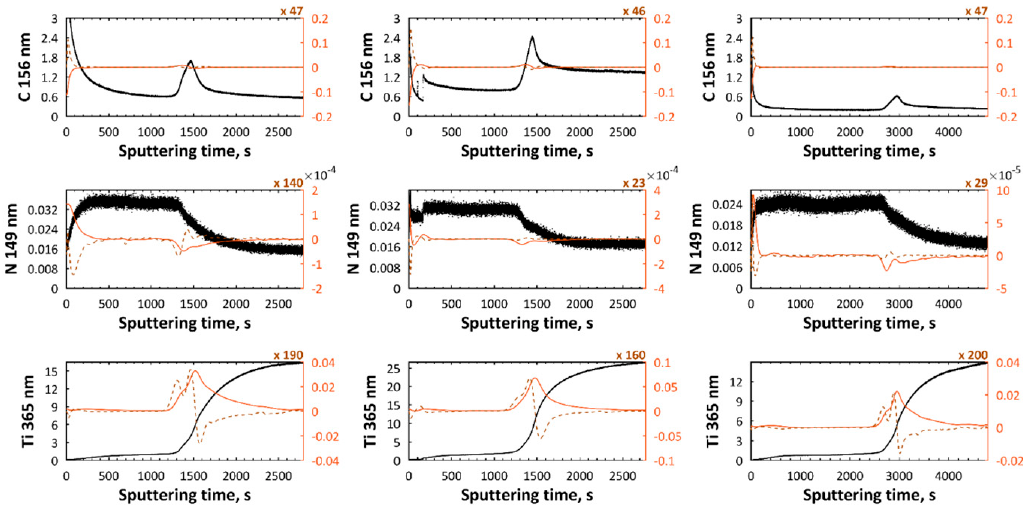
Figure 11. GDEOS signals (black) with first (red continuous line) and second (brown dashed line) derivatives for samples after PEO processing obtained in the electrolyte composed of 250 g/L Mg(NO 3 ) 2 ·6H 2 O and 250 g/L Zn(NO 3 ) 2 ·6H 2 O in H 3 PO 4 at three voltages, 500 V, 575 V, and 650 V.